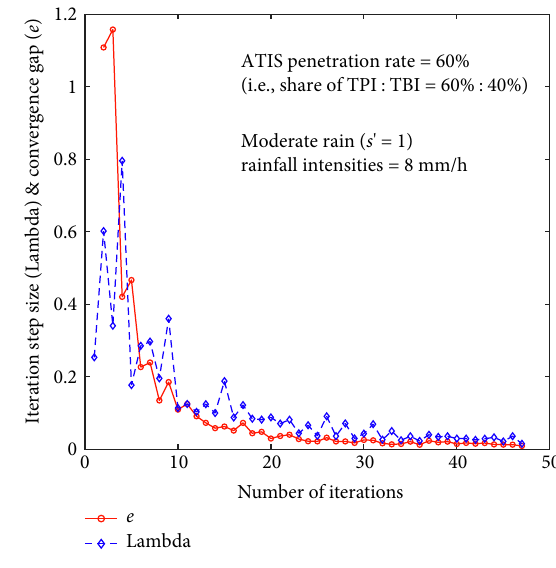
Figure 9: Convergence curves in case